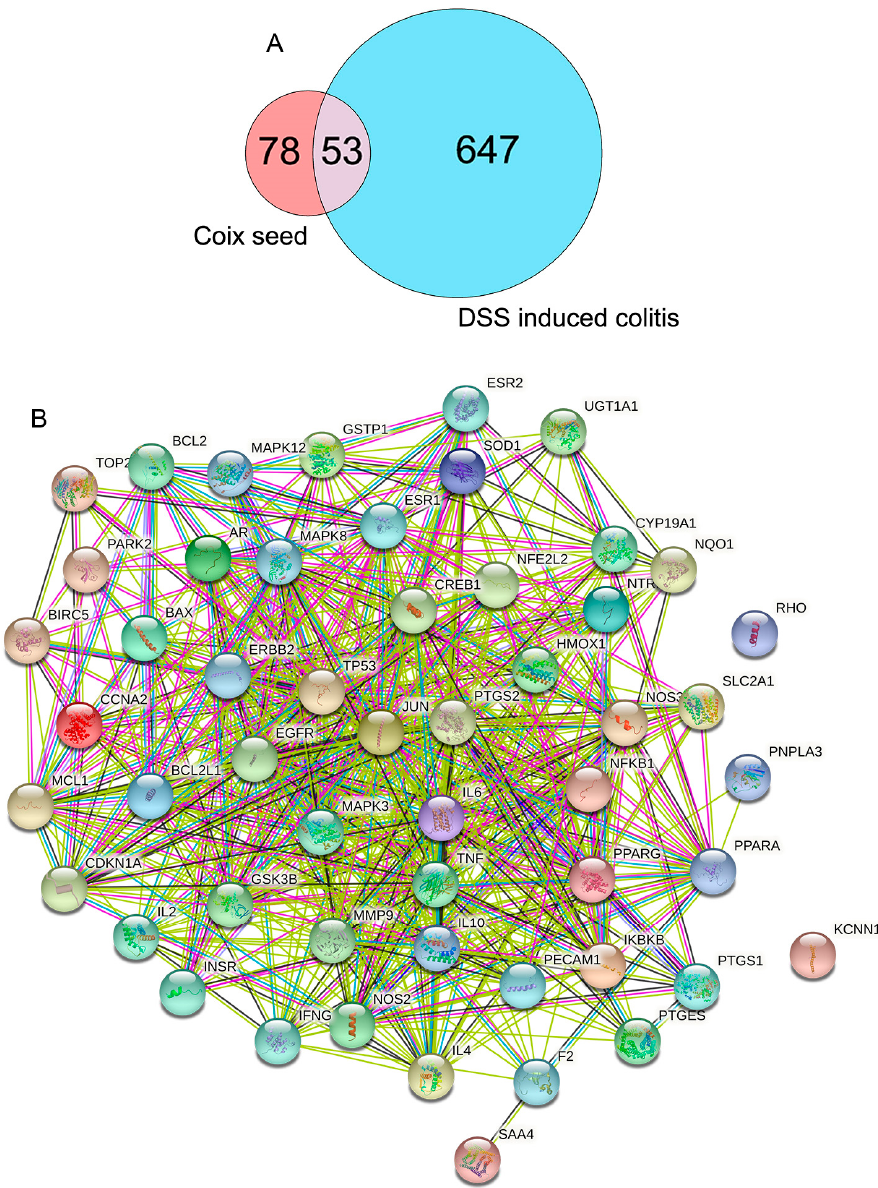
Figure 4. The gene targets of CSF and DSS-induced colitis. ( A ) The overlapping gene targets of CSF and DSS-induced colitis. ( B ) The protein–protein interaction (PPI) network of the 53 key targets constructed by STRING.